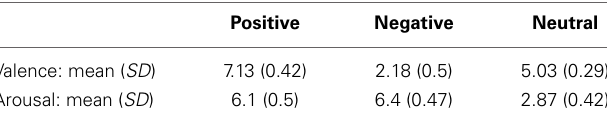
Table 1 | The affective ratings of the selected IAPS pictures for positive, negative and neutral categories.